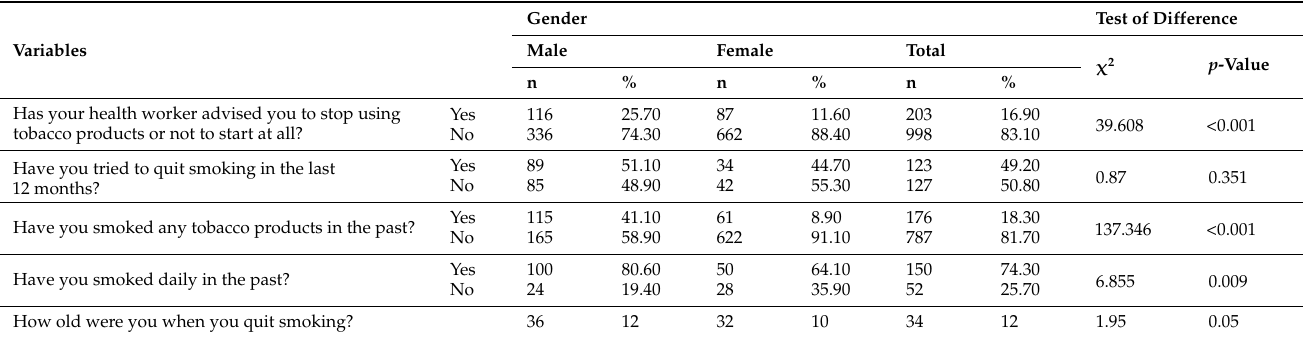
Table 5. Characteristics of tobacco cessation experience, n =